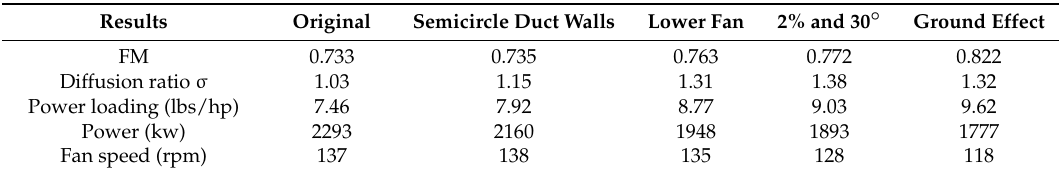
Table 2. The improvement of lift efficiency (the lift was 10.433